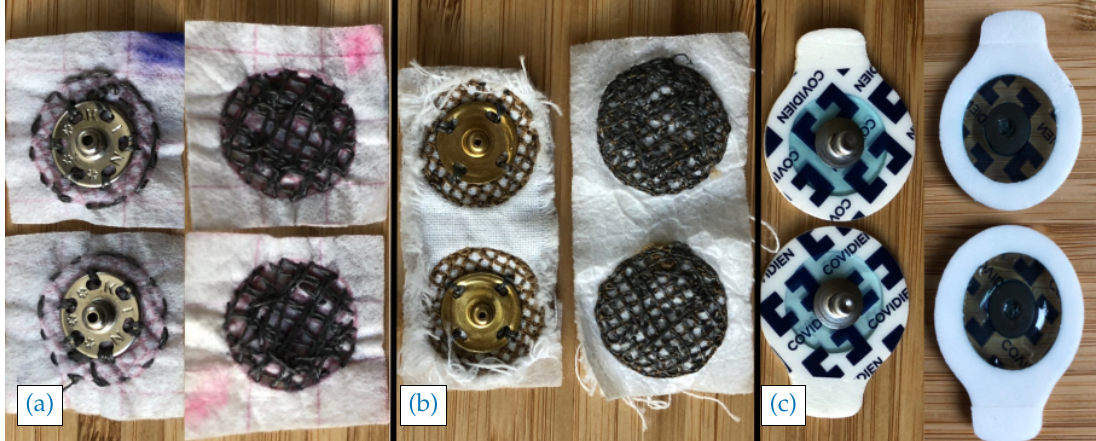
Figure 3. Electrodes used for the experiments. Top and back of: (a) the two HSE; (b) the two MSE; and (c) a pair of GE used for SEMG functionality evaluation. For both types of textile electrode, the back side (consisting of the conductive stainless-steel thread) goes against the skin during recording and the top side (with the snap-fastener) faces